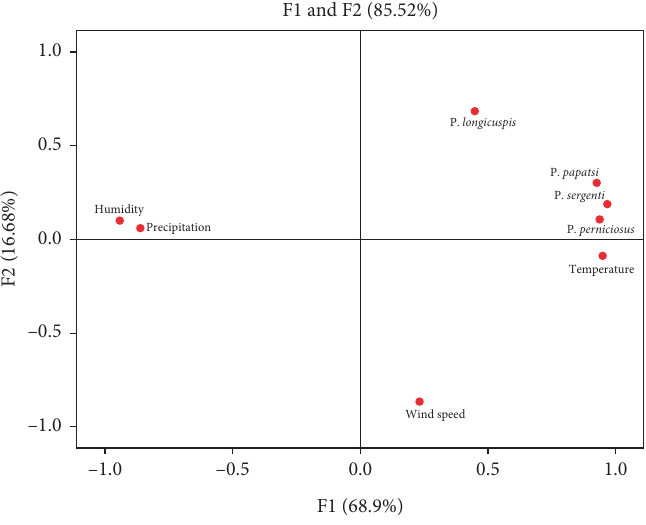
Figure 5: Result of principal component analysis